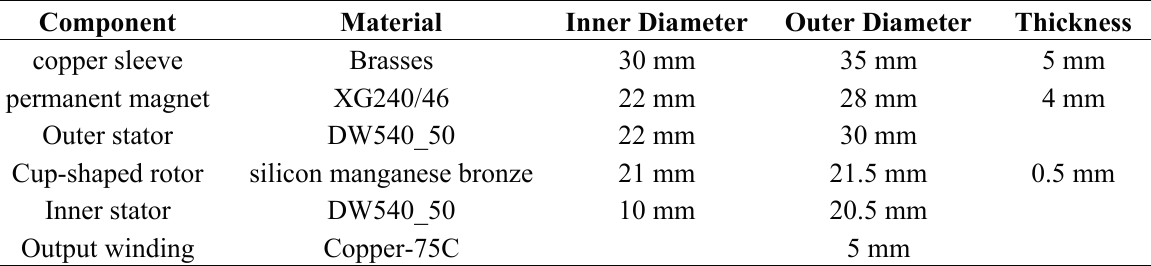
Table 1. Main structural parameters of the